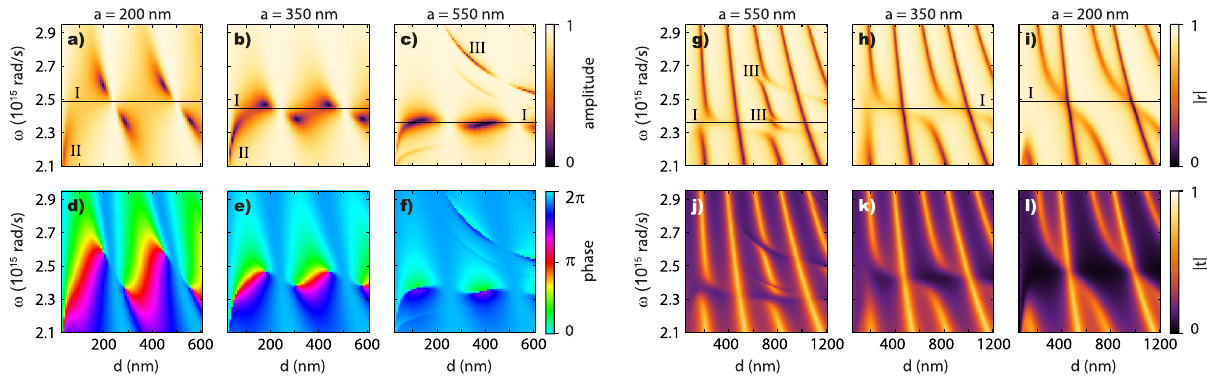
Figure14: COMSOLfullwavesimulationresultstobenchmarkthetransfermatrixmodelpredictionsfortheSalisburyscreencase(panelsa – c, reflection amplitude, d – f reflection phase) and strong coupling of etalon resonances with plasmon resonances (panels g – i resp. j – l for reflectionresp. transmissionamplitude). The x -axes start at 24nm gapresp. 48 nm forthe single-mirror resp. doublemirror case. Parameters have been chosen to best compare to Figure 2 resp. Figure 5. Letters “ I ” indicate the bare lattice resonance frequency, which depends on density. At very small separations to the mirror, the resonances red shift due to near fi eld coupling with the mirror, labeled as “ II ” . At the largest pitches grating wave vector assisted coupling into guided modes and high wave vector etalon resonances can occur at the sharp features labeled as “ III ” . Note that these themselves can show strong coupling with the etalon resonances in panel